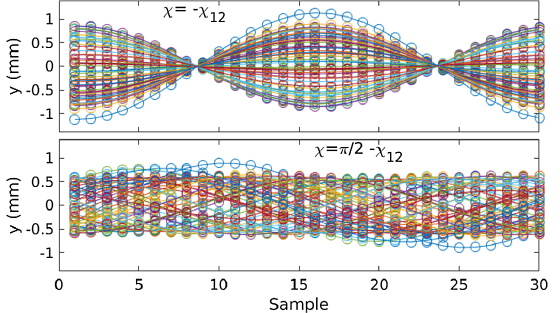
FIG. 5. Comparison of vertical orbit samples for the SPEAR3